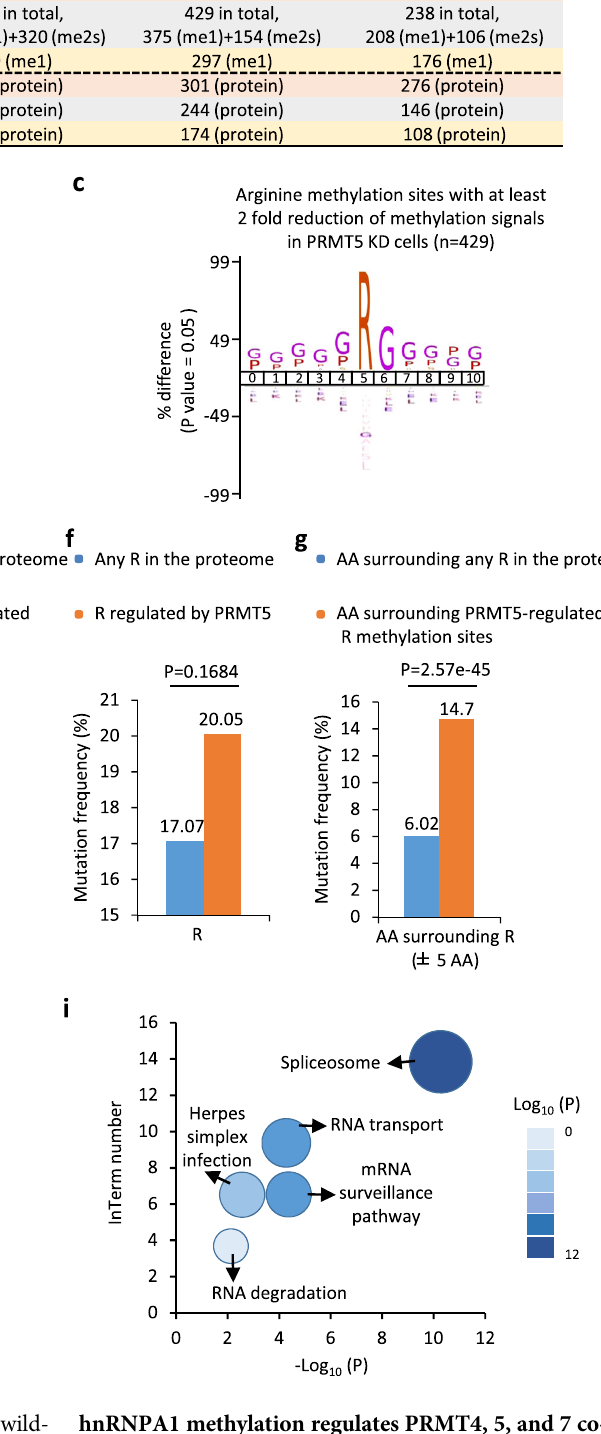
events tested (Supplementary Fig. 4l, m). The expression of wild- type and enzymatically inactive mutants was examined by immunoblotting analysis (Supplementary Fig. 4n). Taken together, PRMT4, 5, and 7 change the alternative splicing of many genes, and in particular, they tend to regulate alternative splicing in the same